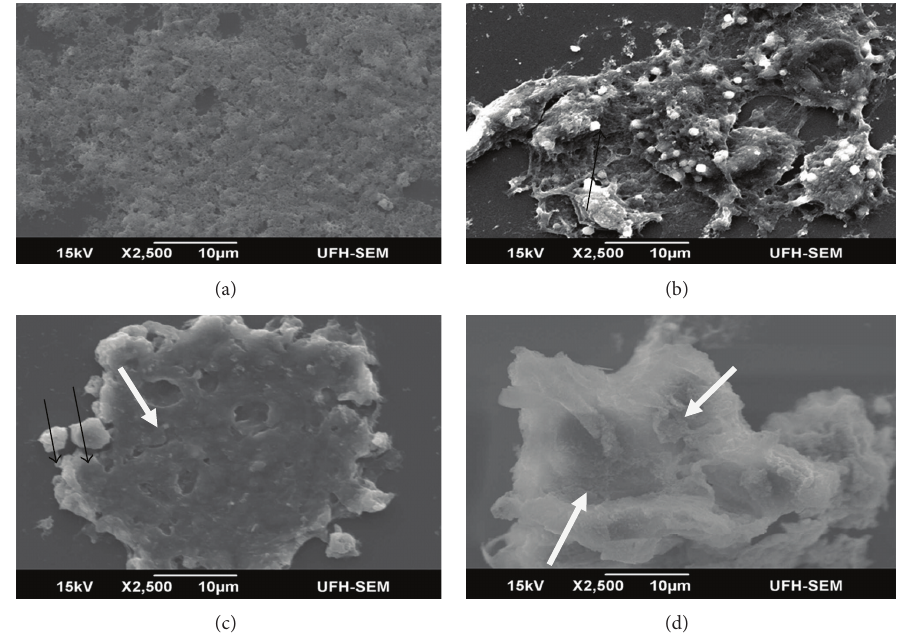
Figure 5: Scanning electron micrographs: (a) untreated MCF7 cells (control), (b) MCF-7 cells treated with curcumin (60 𝜇 M) (positive control), note clumping and margination culminating to budding of the cells and formation of apoptotic bodies, (c) treated MCF7 cells in IC 50 concentration (87.6 𝜇 g/mL), (d) treated MCF7 cells in IC 50 × 4 concentration note disintegration and blebbing. Apoptotic body (thin black arrow), thick white arrow, cell